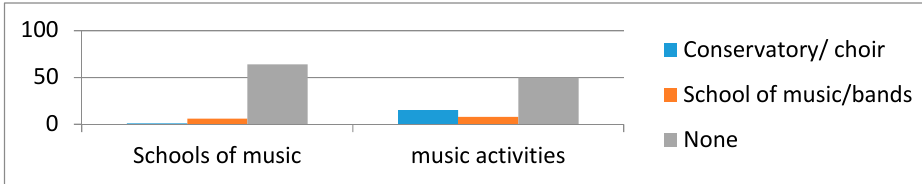
Figure 2. Music education out of school and music